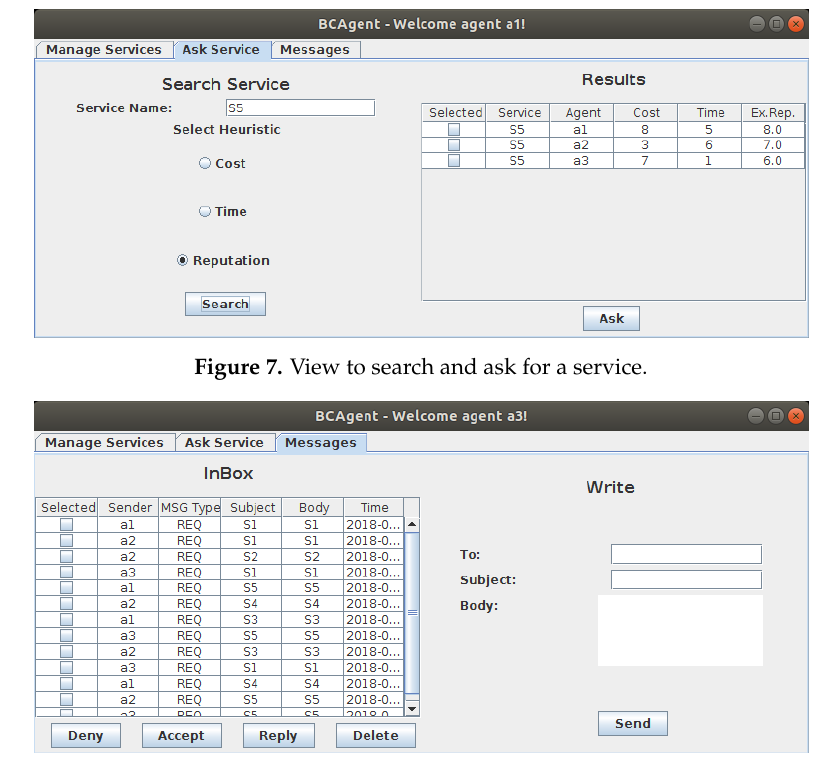
Figure 8. View to reply and send